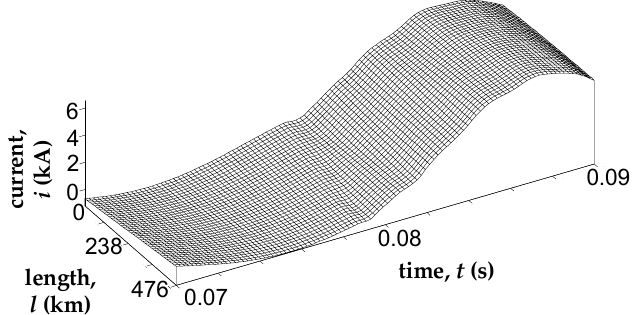
Figure 15. Temporal–spatial waveform of phase A voltage in the time range t ∈ (0.07; 0.09) s. Since the end of the power line is short-circuited, the voltage (Figure 15) is near zero, rising gradually towards the line’s start and adopting the values of the line supply voltage. Figure 16 shows the temporal–spatial waveforms of phase A current in the time range t ∈ (0.07; 0.09), which represents the short-circuit processes at t = 0.08 s.